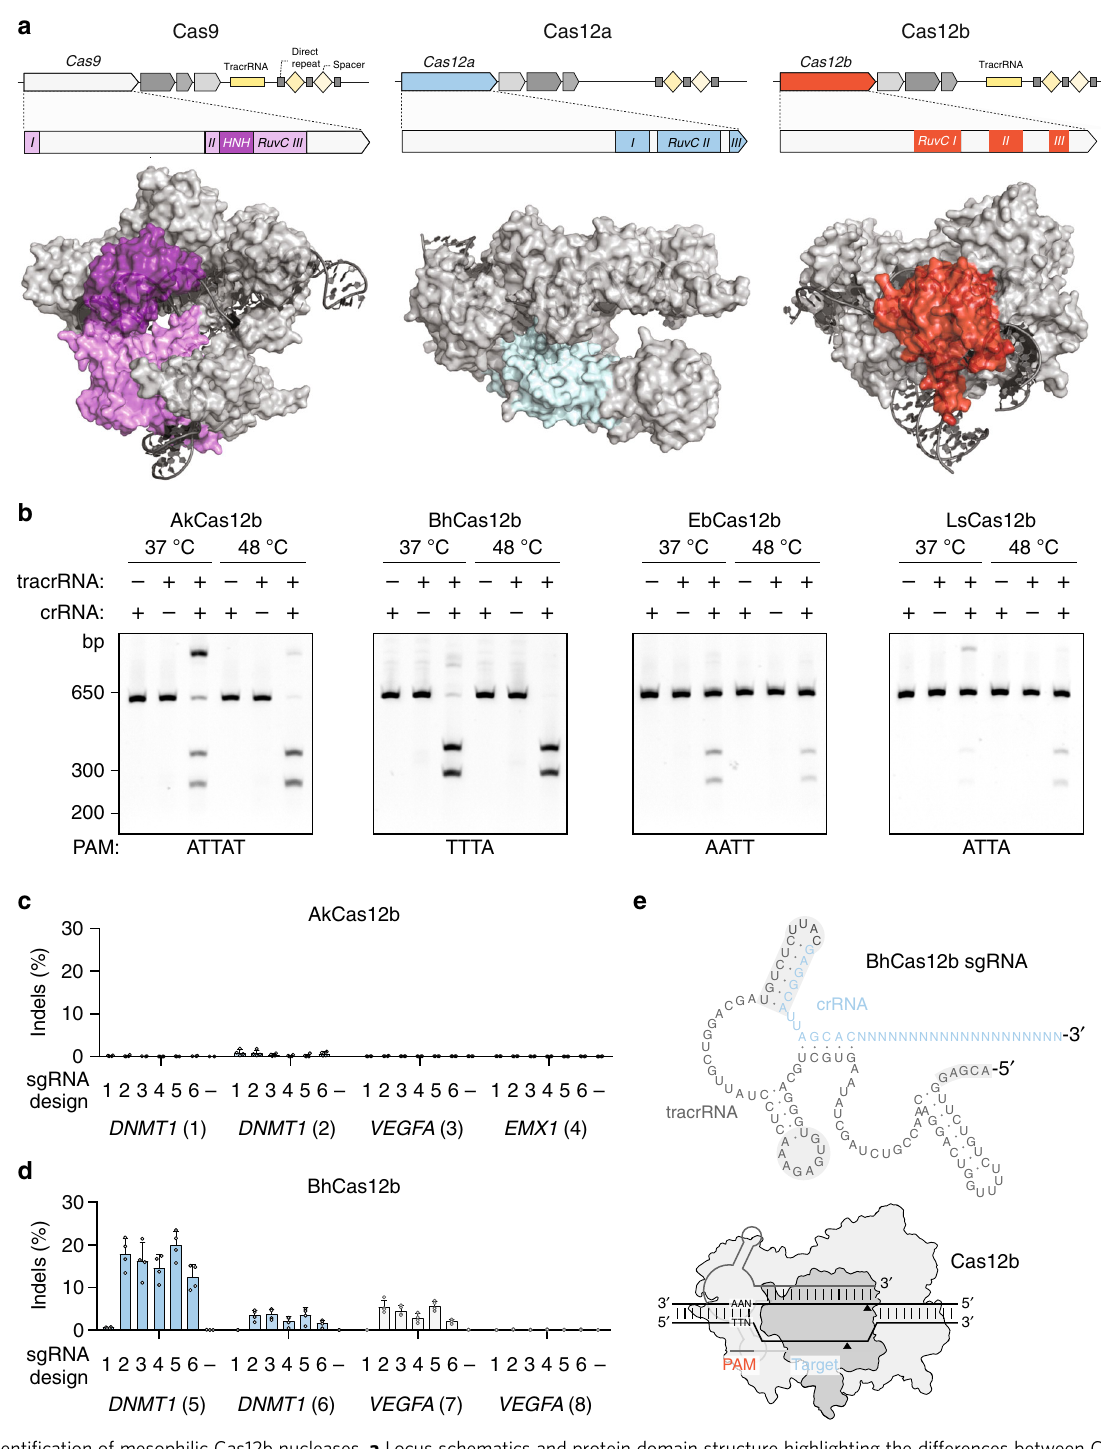
Fig. 1 Identi fi cation of mesophilic Cas12b nucleases. a Locus schematics and protein domain structure highlighting the differences between Cas9, Cas12a, and Cas12b nucleases. Crystal structures of SpCas9 (PDB:4oo8 [10.2210/pdb4OO8/pdb]), AsCas12a (PDB:5b43 [10.2210/pdb4OO8/pdb]), and AacCas12b (PDB:5u30 [10.2210/pdb5U30/pdb]). b In vitro reconstitution of Cas12b systems with puri fi ed Cas12b protein and synthesized crRNA and tracrRNA identi fi ed through RNA-Seq. Reactions were carried out at the indicated temperatures for 90 min and 250 nM Cas12b protein. c, d AkCas12b and BhCas12b indel activity in 293T cells with six sgRNA variants. Error bars represent s.d. from n = 4 replicates. See Supplementary Fig. 3b, c for sgRNA sequences. e Schematic of BhCas12b sgRNA design 1 with gray shading highlighting the location of changes to the guide design (see Supplementary Fig. 3 for exact sequences of guide design variants 2 – 6). Source data are provided as a Source Data fi